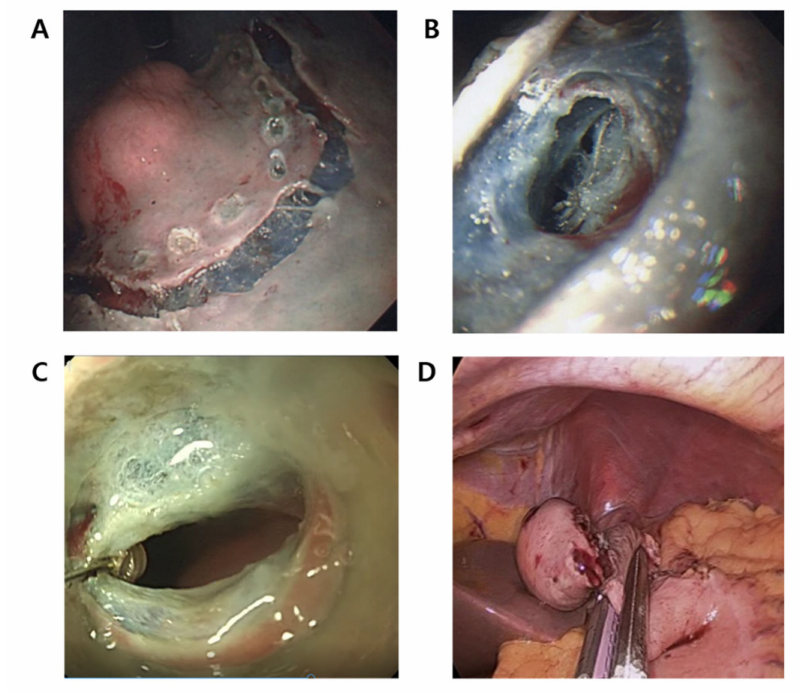
Figure 1. The laparoscopic and endoscopic cooperative surgery (LECS) procedures. ( A ) Endoscopic submucosal resection around the tumor. ( B ) Introduction of a small puncture in the gastric wall on the mucosal incision line with a fixed flexible snare. ( C ) Endoscopic full-thickness resection (EFTR) along the precut mucosal incision line until one-third or half of the circumference is resected. ( D ) Closure at the incision line using a laparoscopic stapling